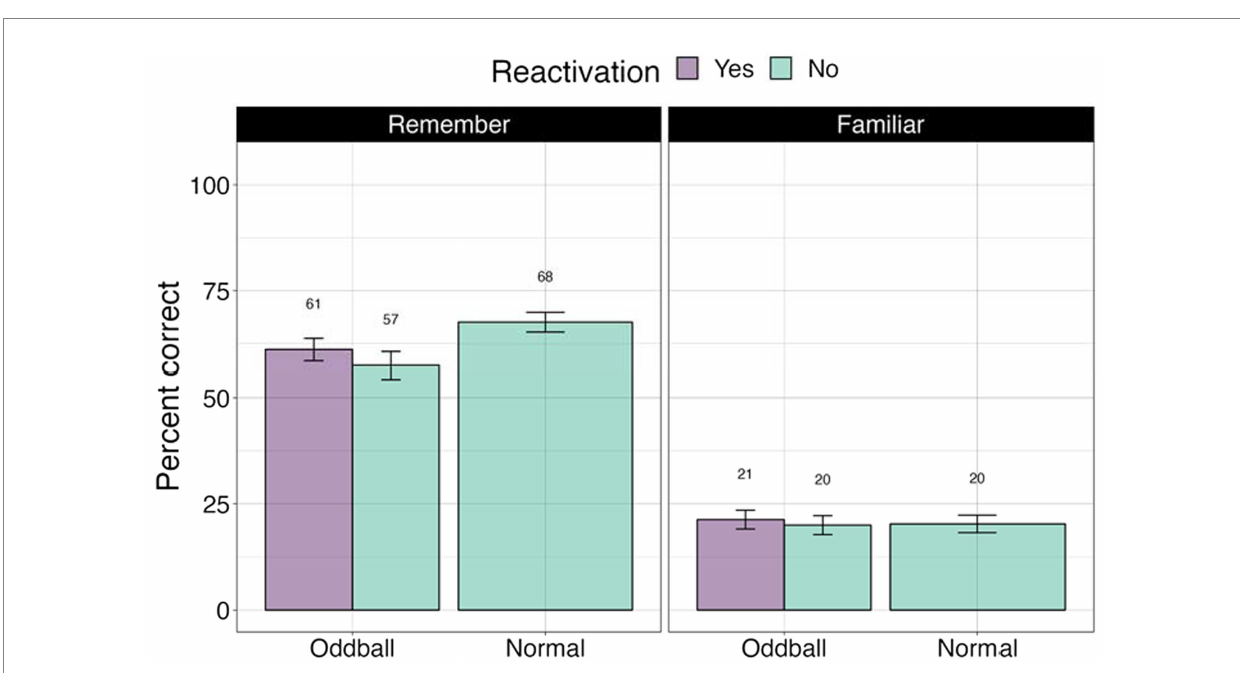
FIGURE 9 Percent correct for the visual recognition test by self-reported confidence levels in Experiment